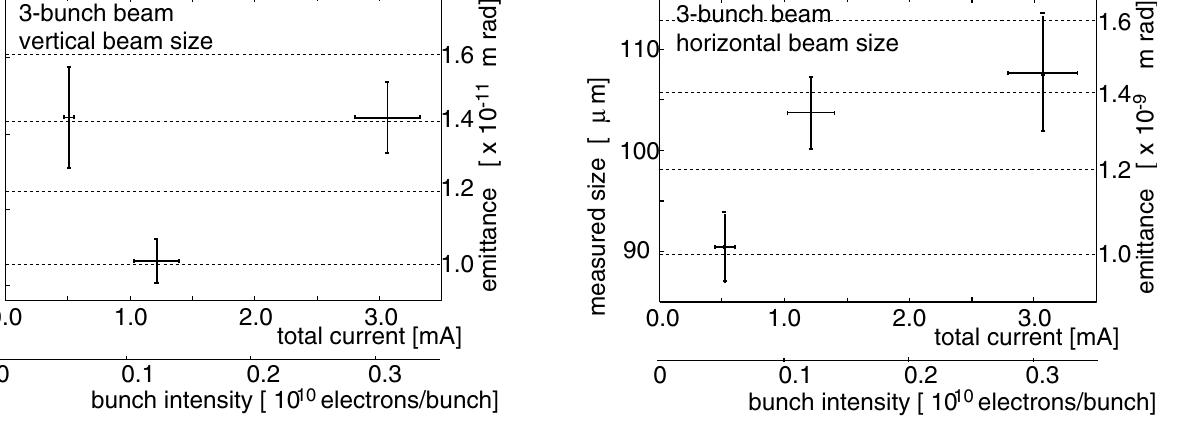
FIG. 13. Horizontal emittance of the 3-bunch beam vs the electron